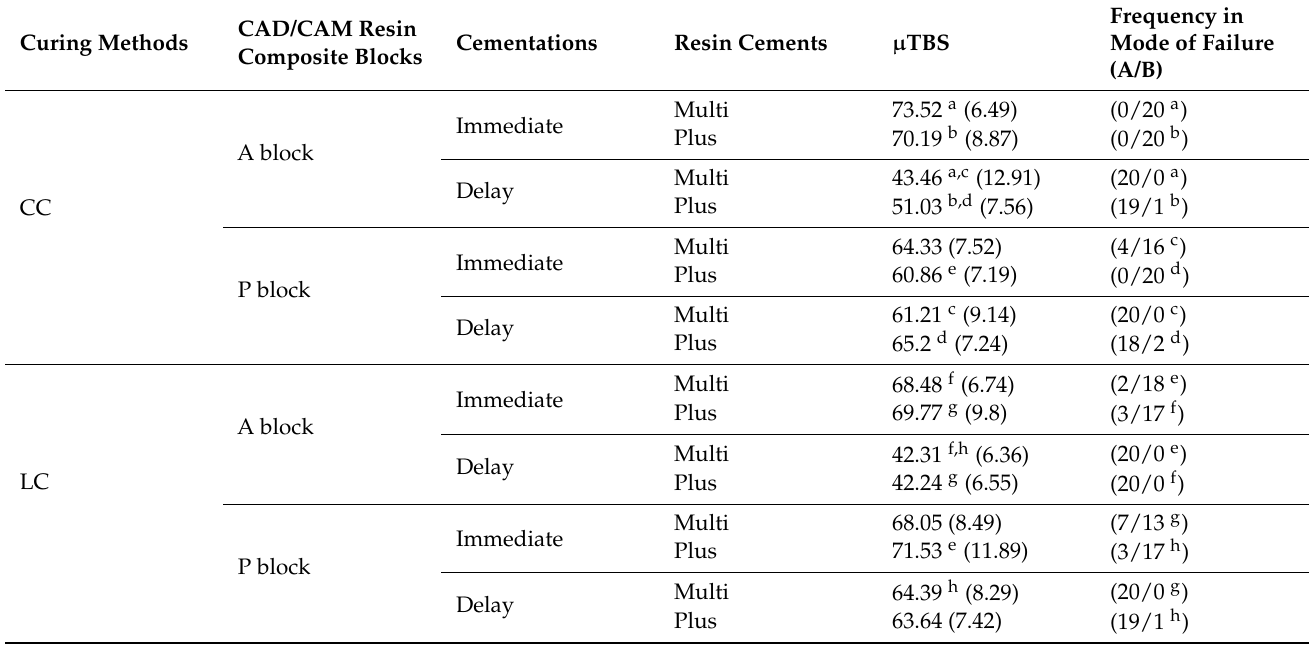
Table 2. Results of µ TBS and frequency in mode of